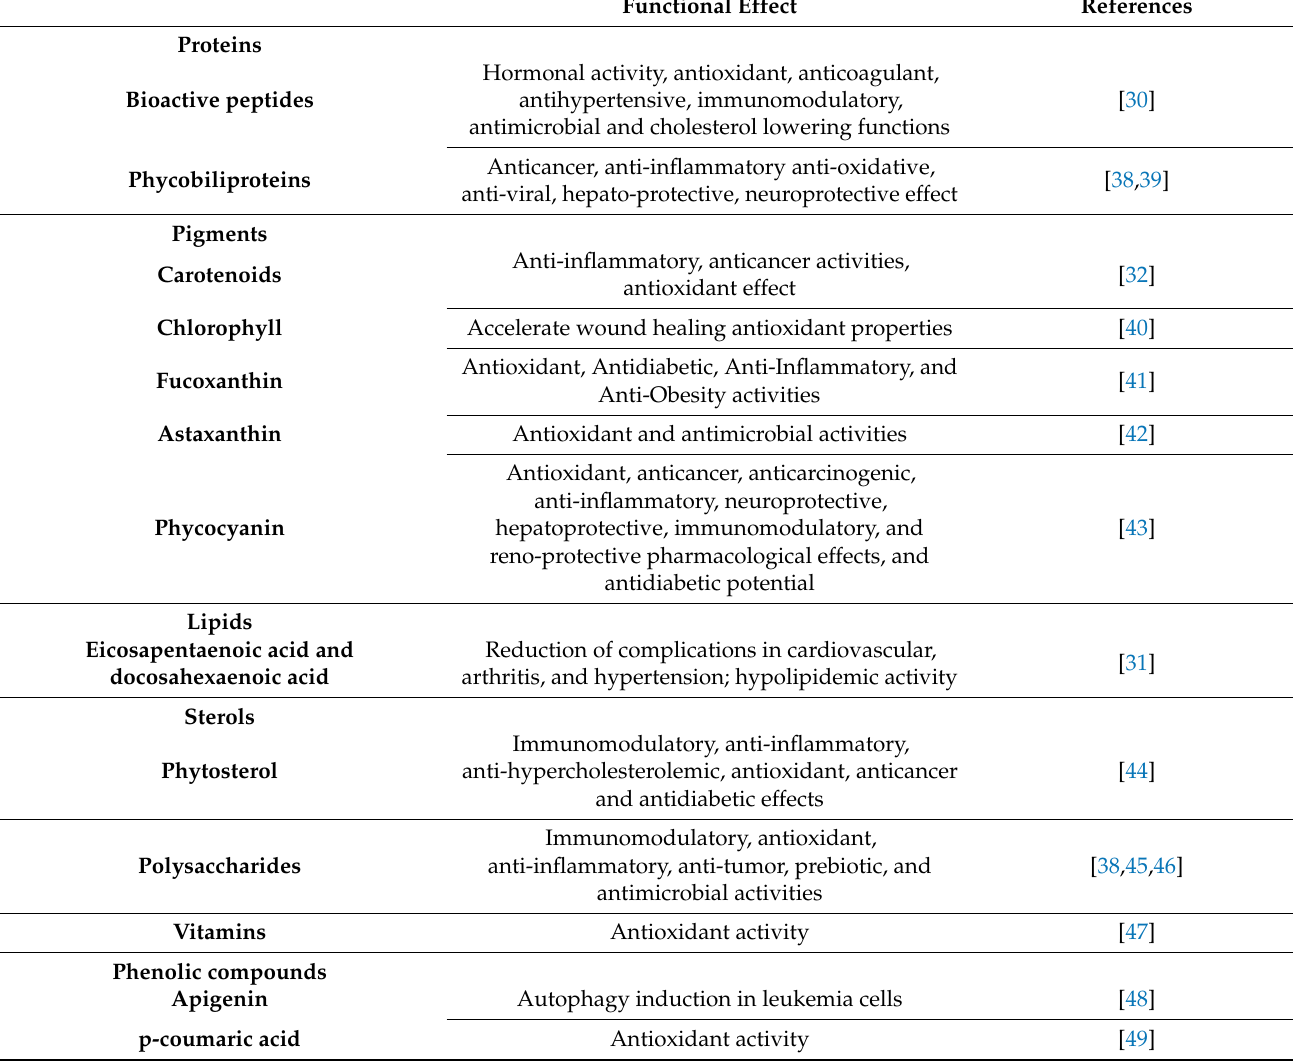
Table 1. Main functional effects ascribed to microalgae’s principal